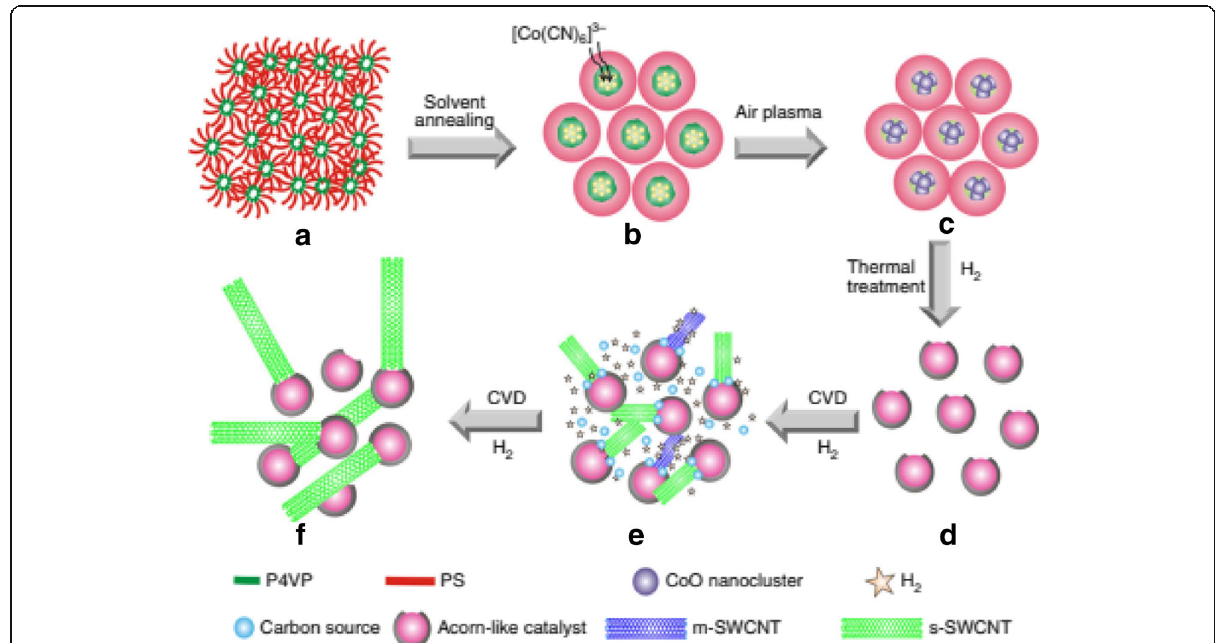
Fig. 14 Step-by-step description of growth of s-SWCNTs with narrow diameter distribution using carbon-coated Co nanoparticle catalysts. Solvent annealing, use of air plasma followed by thermal treatment produced a yield of ~95% s-SWCNTs with diameters of about 1.7 nm. a Poly-(styrene- block-4-vinylpyridine) film self-assembled into vertical nanocylinders. b Formation of phase-separated nanodomains from the vertical nanocylinders and adsorption of K3[Co(CN)6]3 catalysts onto them. c CoO nanoclusters partially surrounded by a polymer layer. d Co catalyst nanoparticles partially coated with carbon to produce acorn-like bicomponent catalysts. e Growth of SWCNTs with a narrow diameter distribution from the partially carbon- coated Co nanoparticles followed by in situ etching of m-SWCNTs. f s-SWCNTs with a narrow band-gap distribution. Adapted from